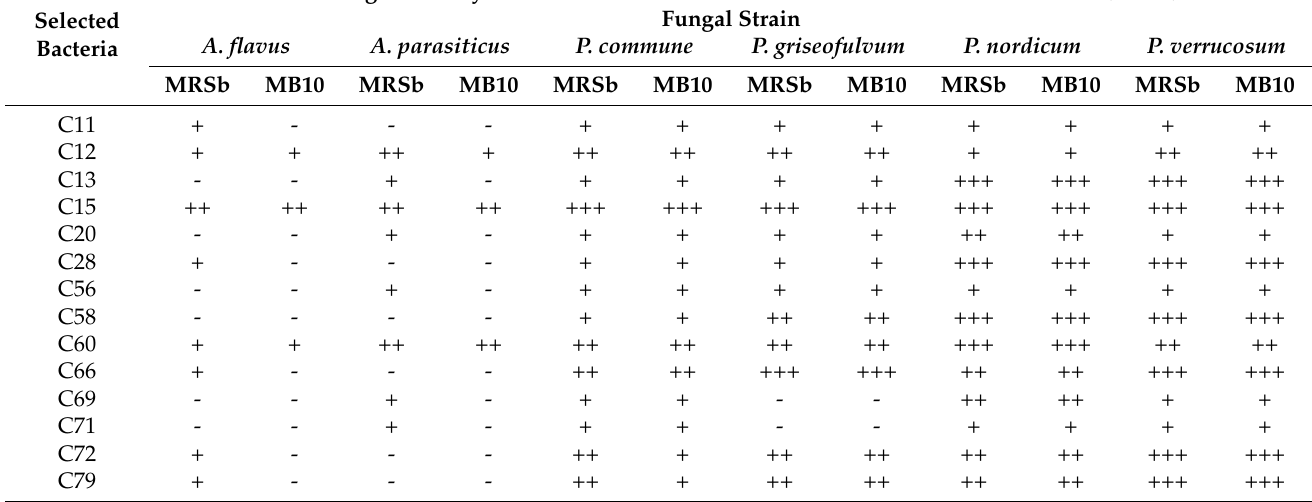
Table 3. Antifungal activity of bacterial free supernatant (BFS) extract in agar diffusion method. LAB fermented MRS broth (MRSb) and a meat broth (MB10) for 48 h at 37 ◦ C. Then, the supernatant was freeze-dried and resuspended at a concentration of 250 g/L. These bacteria were previously selected due to their antifungal effect in the overlay